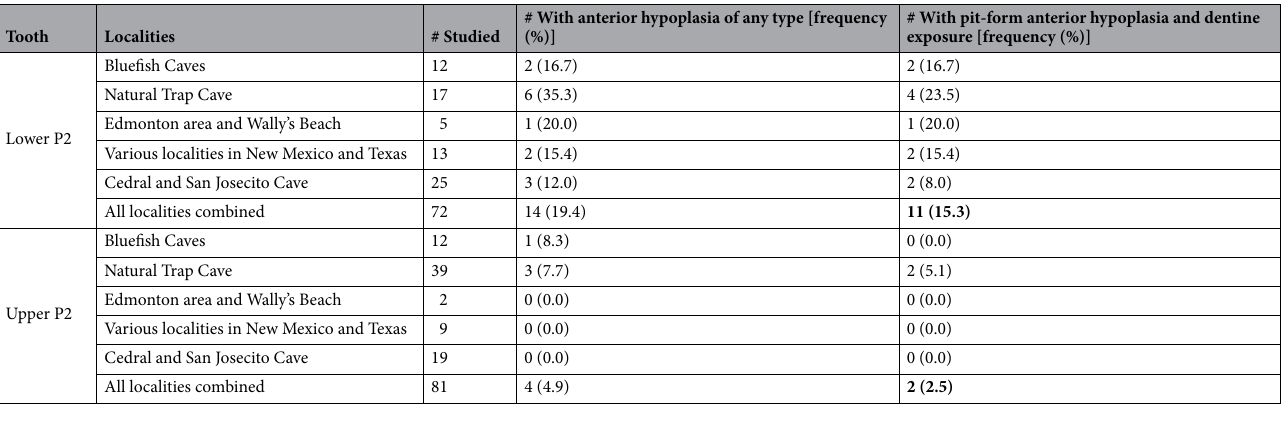
Table 1. Frequency of enamel hypoplasia on anterior side of lower and upper second premolars in study samples from Pleistocene sites in North America. Bold value indicates the frequency of specimens with anterior pit-form hypoplasia with dentine exposures